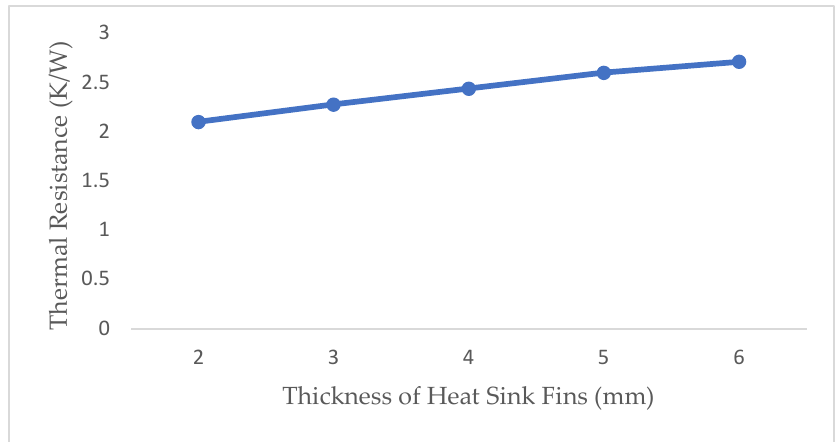
Figure 9. Thermal Resistance of Heat Sink.